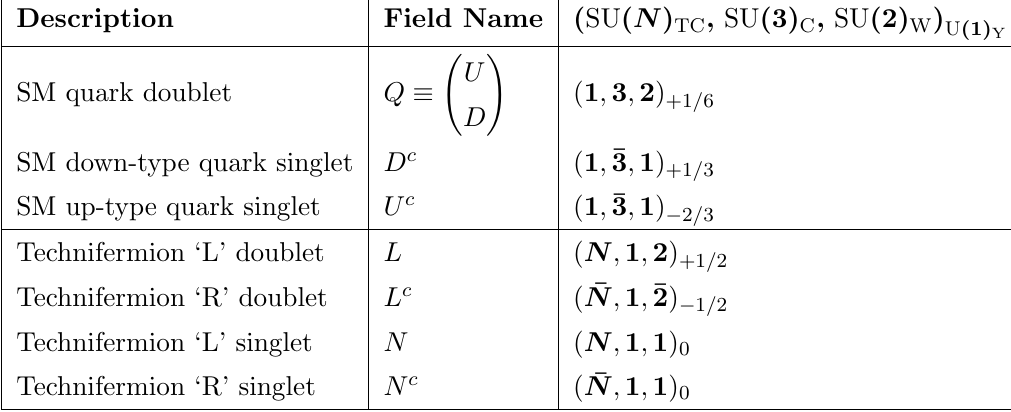
Table 1 . Gauge charges and representations for the fermion matter content. For the non-Abelian factors we give the representation, and for the hypercharge group we give the charge. All